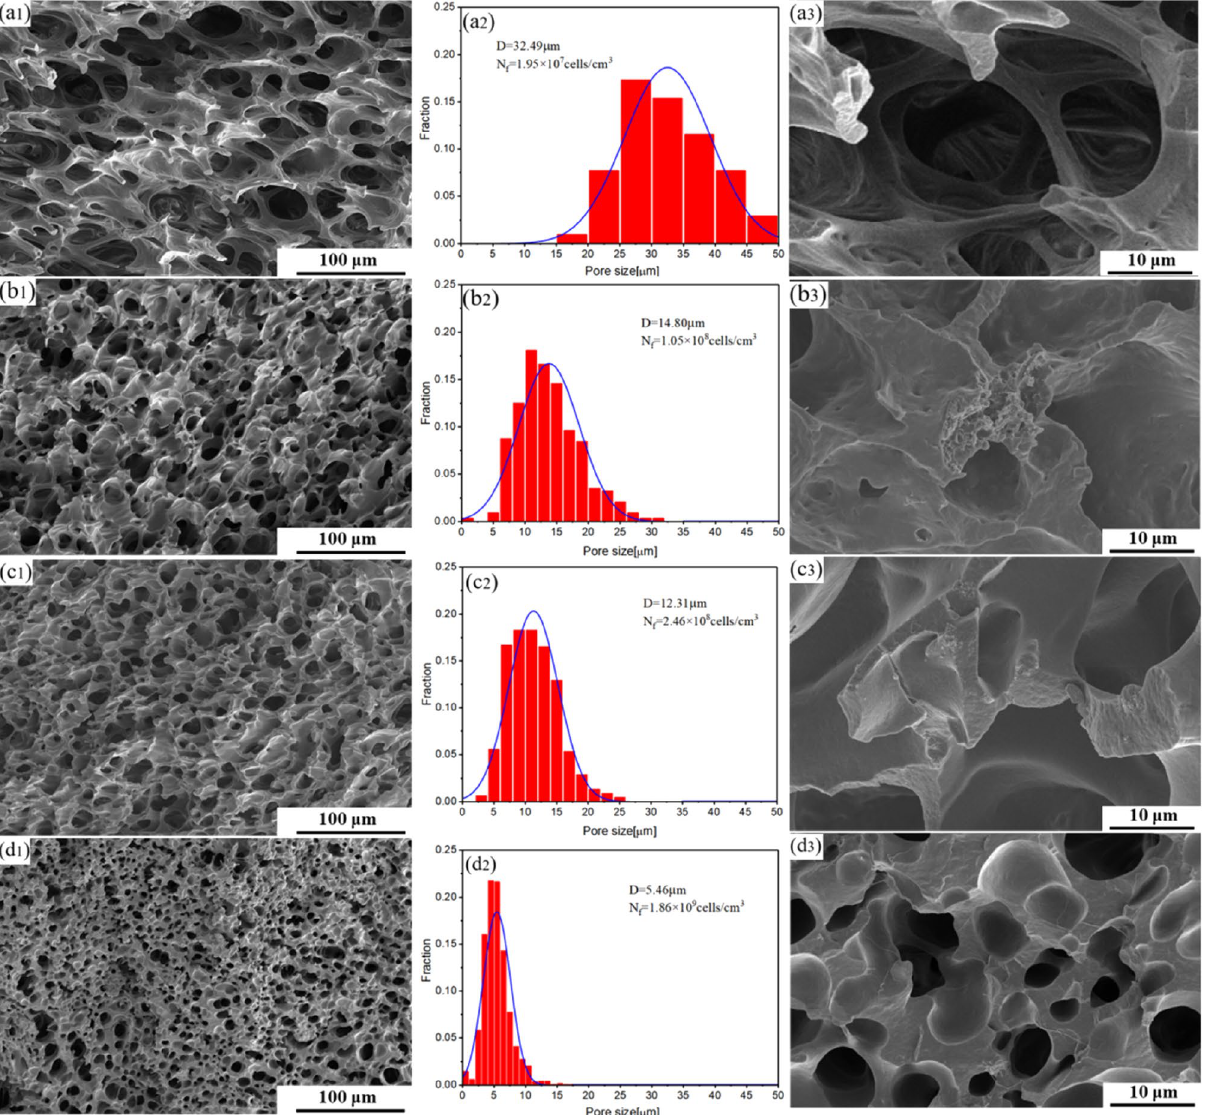
Figure 10. SEM micrographs and size distribution of PBS and PBS/PTFE foams: ( a ) neat PBS, ( b ) PBS/P220, ( c ) PBS/P5, and ( d ) PBS/P500.